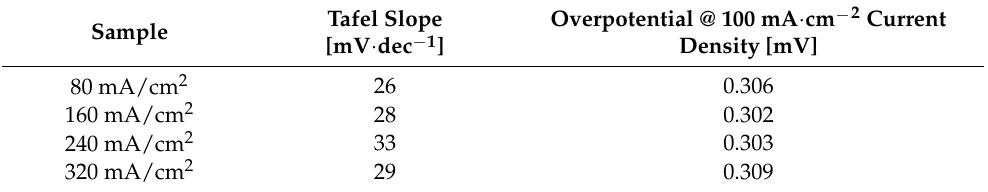
Figure 3. I-E curves (LSV) of electrodeposited Ni–Zn–Fe on Ni foam prepared with different current density in the bath (E) (Condition: scan rate = 0.1 mV/s, temperature = 25 ◦ C, KOH = 1 M). Table 1. Electrochemical overpotentials of OER and Tafel slope values for Ni–Zn–Fe Catalysts tested in 1 M KOH at 298